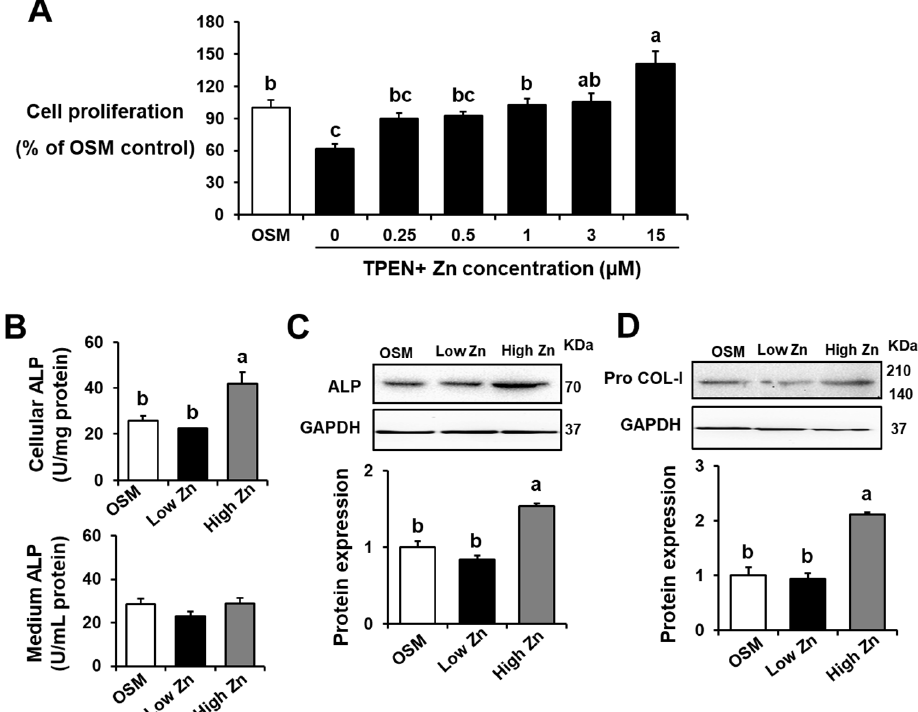
Figure 1. Effects of low Zn on cell viability, alkaline phosphatase (ALP) activity, osteogenesis-related protein expression in MC3T3-E1 cells. OSM is the normal osteogenic differentiation medium without Zn chelator, 5 µ M TPEN. 1 µ M (low Zn) and 15 µ M (high Zn) are the media Zn added as designated with 5 µ M TPEN. ( A ) Cell viability of MC3T3-E1 cells cultured with various concentrations of Zn (0, 0.25, 0.5, 1, 3, and 15 uM) with TPEN was measured by the MTT assay. The results are shown as % of OSM. ( B ) ALP activity of culture media or MC3T3-E1 cells treated with either low or high Zn was measured as a marker for osteoblast maturation. One unit (U) of ALP activity refers to a nmol p -nitrophenol/mg of protein/min in cells and a nmol p -nitrophenol/mL/min in media. ( C , D ) The protein expression of osteogenesis-related proteins, ALP and Pro COL-1, was analyzed by western blotting. GAPDH was utilized as loading control for protein normalization. Data represent means ± SEM. One-way ANOVA model was used to analyze the dataset. Once significance is noted, Tukey’s HSD method was further applied to find significances between groups. Groups with different superscript letters are significantly different from one another, p <